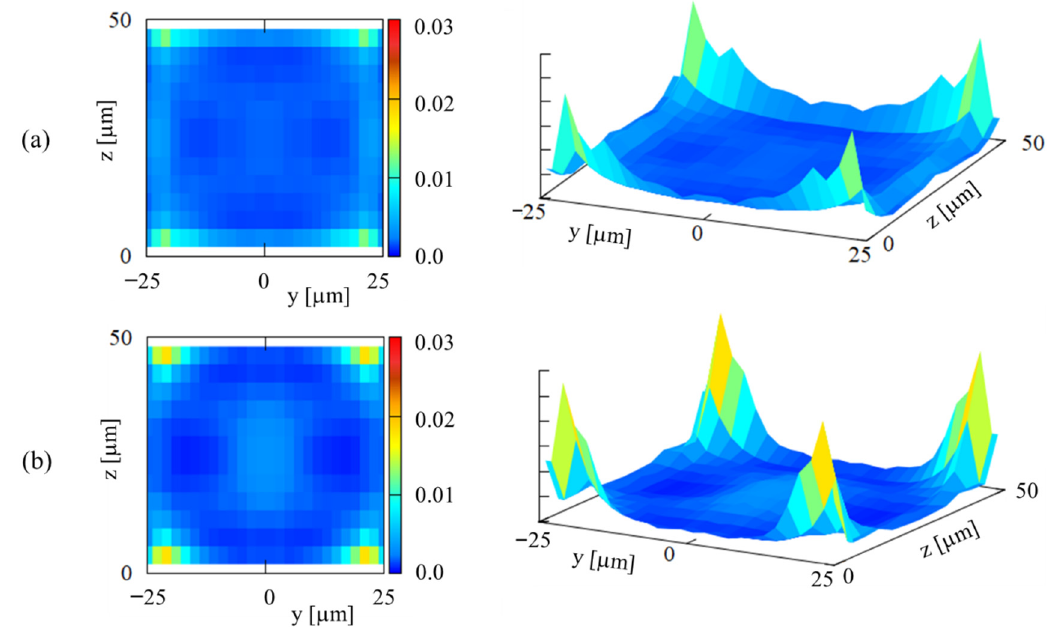
Figure 5. 2D distributions of particles over the square cross-section at ( a ) Ht = 20% and ( b ) Ht = 40%.